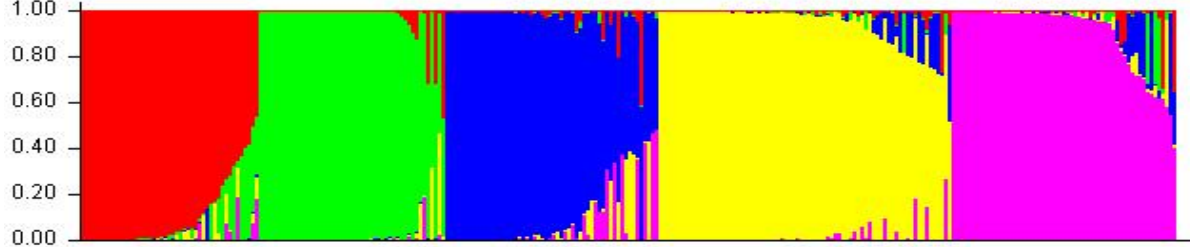
Table 3. Simple sequence repeats markers found significantly ( p < 0.001) associated with turcicum